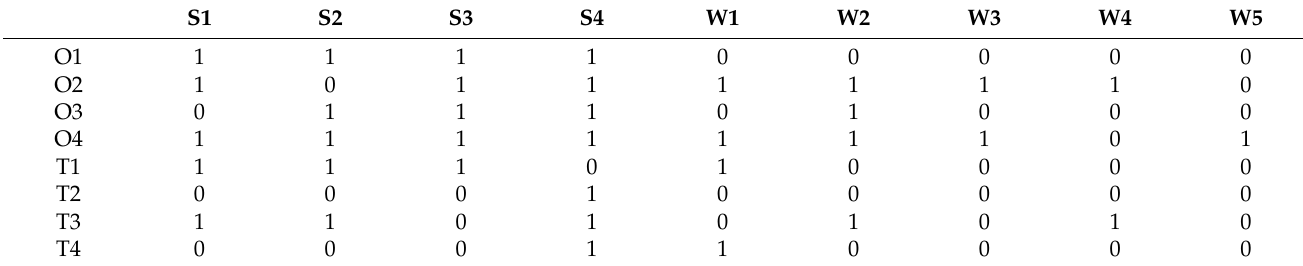
Table A2. TOWS relationships between factors used in the analysis.